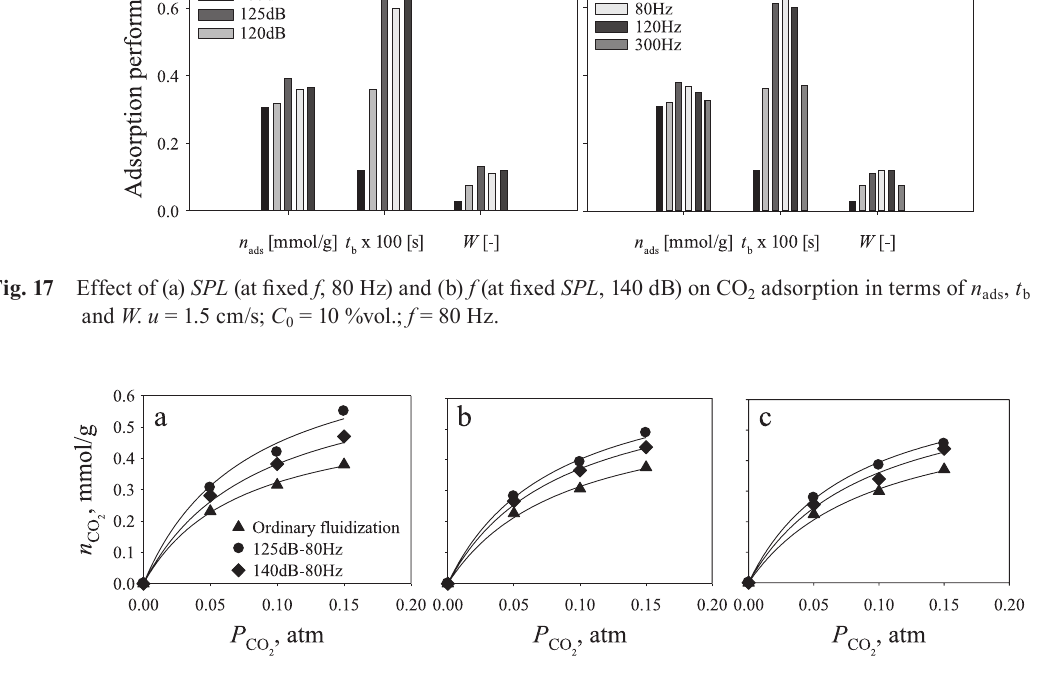
Fig. 18 Activated carbon adsorption isotherms in ordinary and sound-assisted test. (a) u = 2 cm/s; (b) u = 1.5 cm/s; (c) 1